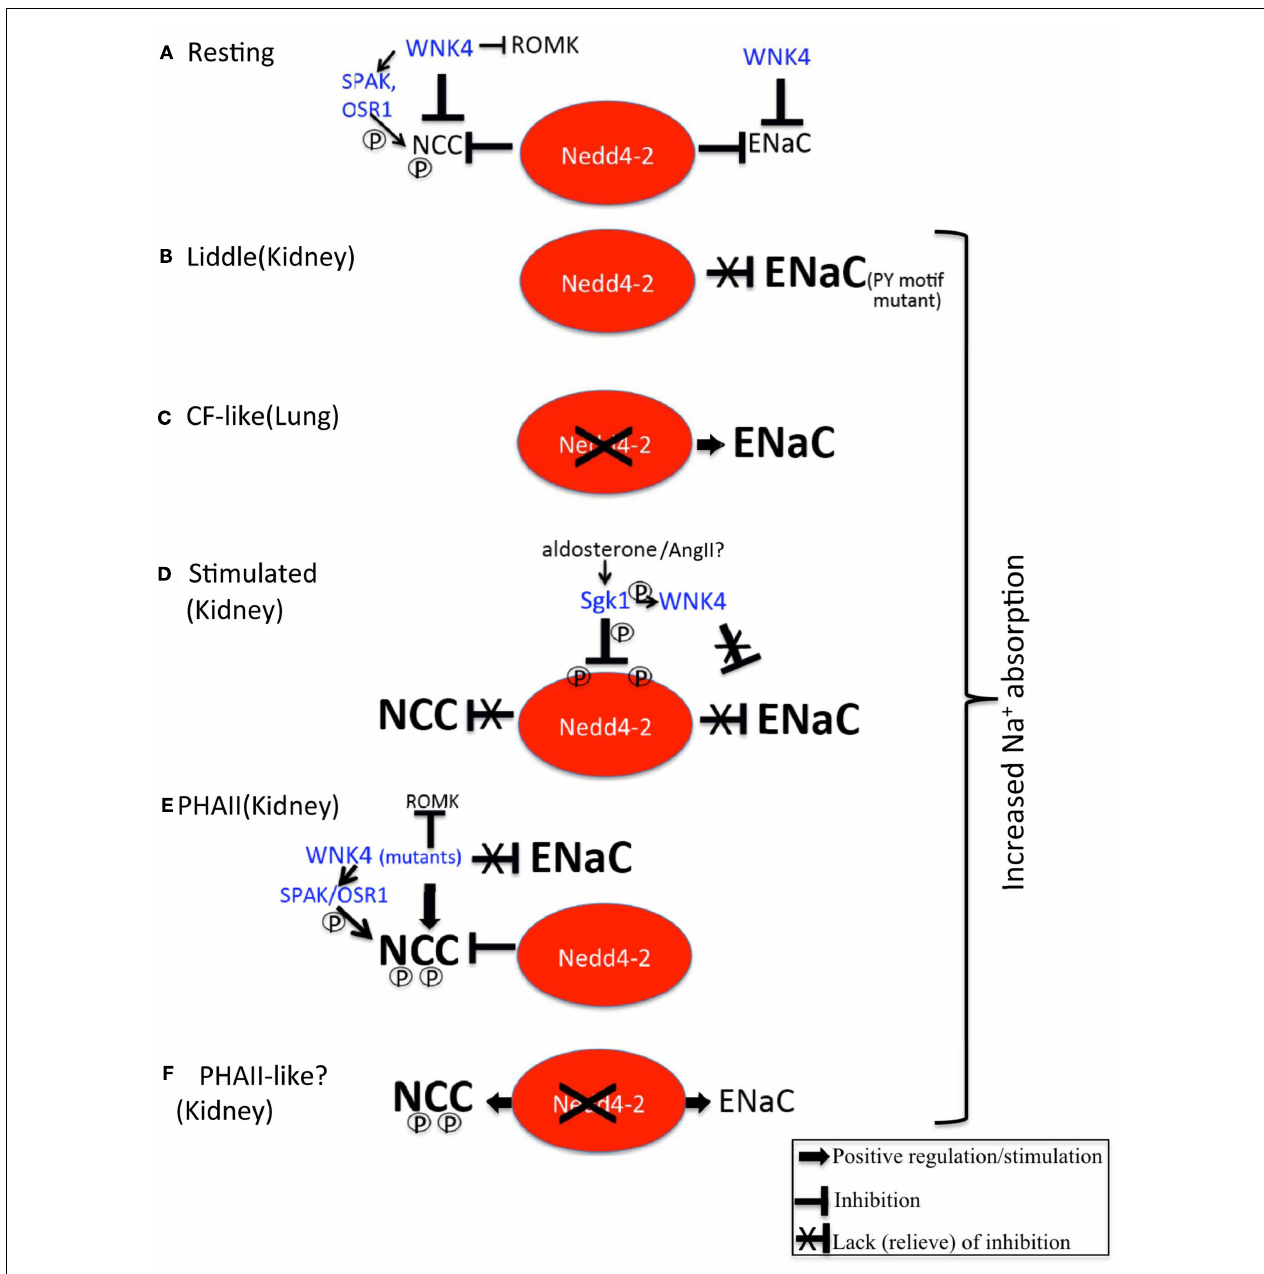
results in increased abundance/function of these Na + absorbing proteins. In addition, phosphorylation ofWNK4 by Sgk1 interferes with the ability of WNK4 to inhibit ENaC. Collectively, this leads to aldosterone-mediated increased in Na + and fluid reabsorption in the kidney, hence to elevated blood pressure. (E) In PHAII,WNK4 mutants either divert NCC to the recycling pathway instead of lysosomal degradation, and/or enhance phosphorylation (and activation) of SPAK/OSR1 and hence of NCC. Both of these effects, coupled with loss of inhibition of ENaC byWNK4, lead to increased Na + reabsorption (and paracellular Cl − permeability) in the kidney, and hence to increased fluid absorption and hypertension. MutantWNK4 also strongly suppresses ROMK, preventing K + excretion and causing hyperkalemia. (F) Knockout of Nedd4-2 in the distal nephron leads to increased abundance and activation of NCC (and ENaC), causing hypertension and possibly mimicking features of